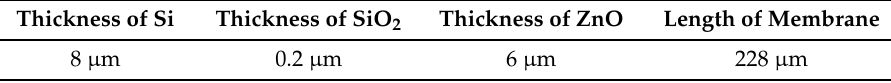
Table 1. Structure parameters of the multi-membrane.